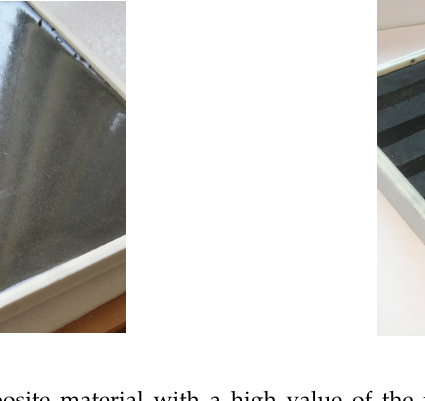
Figure 12. Composite material with a high value of the real part of the dielectric permittivity.